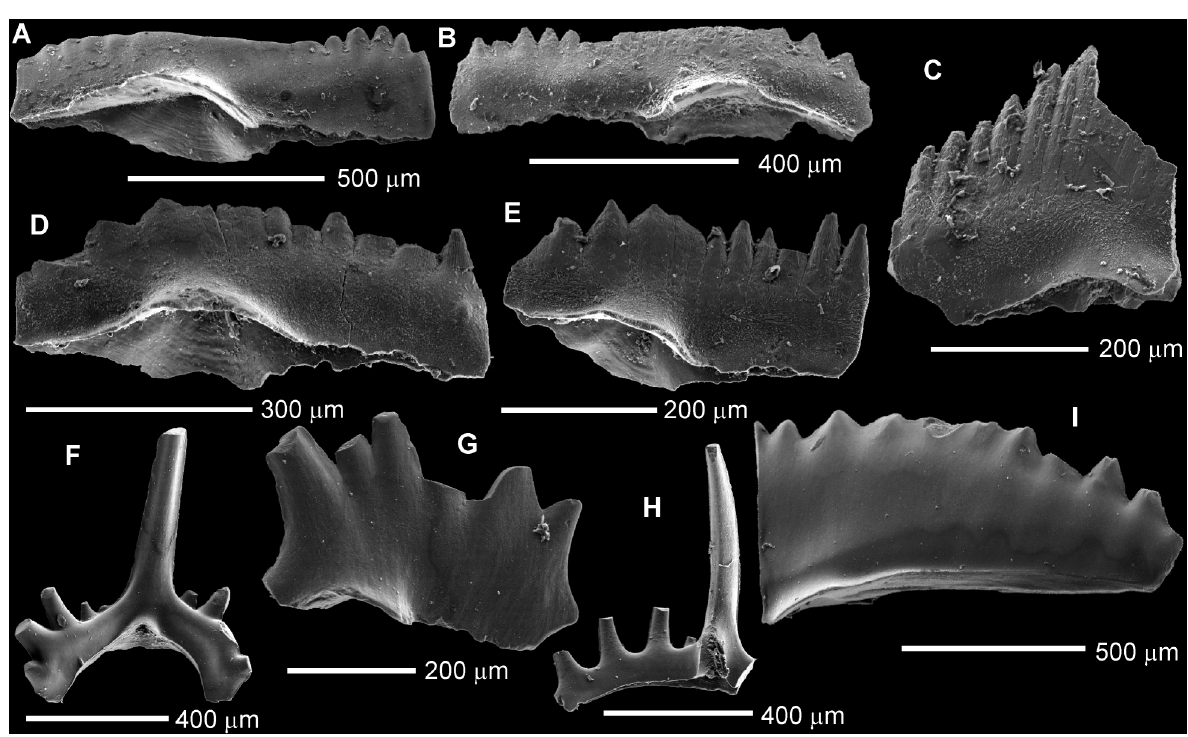
Fig. 3. SEM pictures of stratigraphically significant conodonts from the Ledai-179 core. A (cid:150) C , Ozarkodina bohemica longa , Wenlock, G ė luva Regional Stage, Nev ė (cid:158)is Formation; A, Pa element, VU-CON-L179-001, depth 641.7 m; B, Pa element, VU-CON-L179-002, depth 635.7 m; C, incomplete Pb element with partially broken ventral process, VU-CON-L179-003, depth 635.7 m; D , E , Ozarkodina bohemica bohemica , Pa elements, Wenlock, G ė luva Regional Stage; D, VU-CON-L179-004, depth 619.9 m; E, VU-CON-L179-005, depth 618.9 m; F (cid:150) H , Ctenognathodus sp. S ( sensu Viira & Einasto 2003), Ludlow, Dubysa Regional Stage, Neris Formation, depth 608.5 m; F, Sb element, VU-CON-L179-006; G, almost complete Pa element without dorsal process, VU-CON-L179-007; H, incomplete Sa element, VU-CON-L179-008; I , Ctenognathodus murchisoni , Ludlow, Dubysa Regional Stage, Neris Formation, depth 608.5 m, dorsal part of Pa element, VU-CON-L179-007. Anatomical notations sensu Purnell et al.